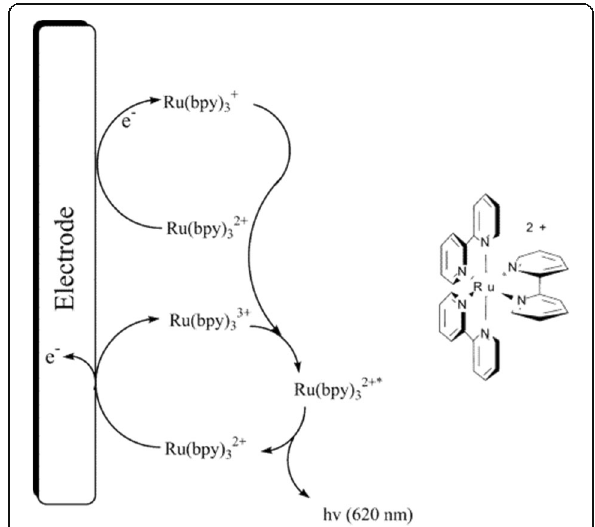
Fig. 17 Structure of Ru(byy) 32+ and a proposed mechanism for Ru(bpy) 33+ /Ru(bpy) 3+ ECL system (reprinted with permission from